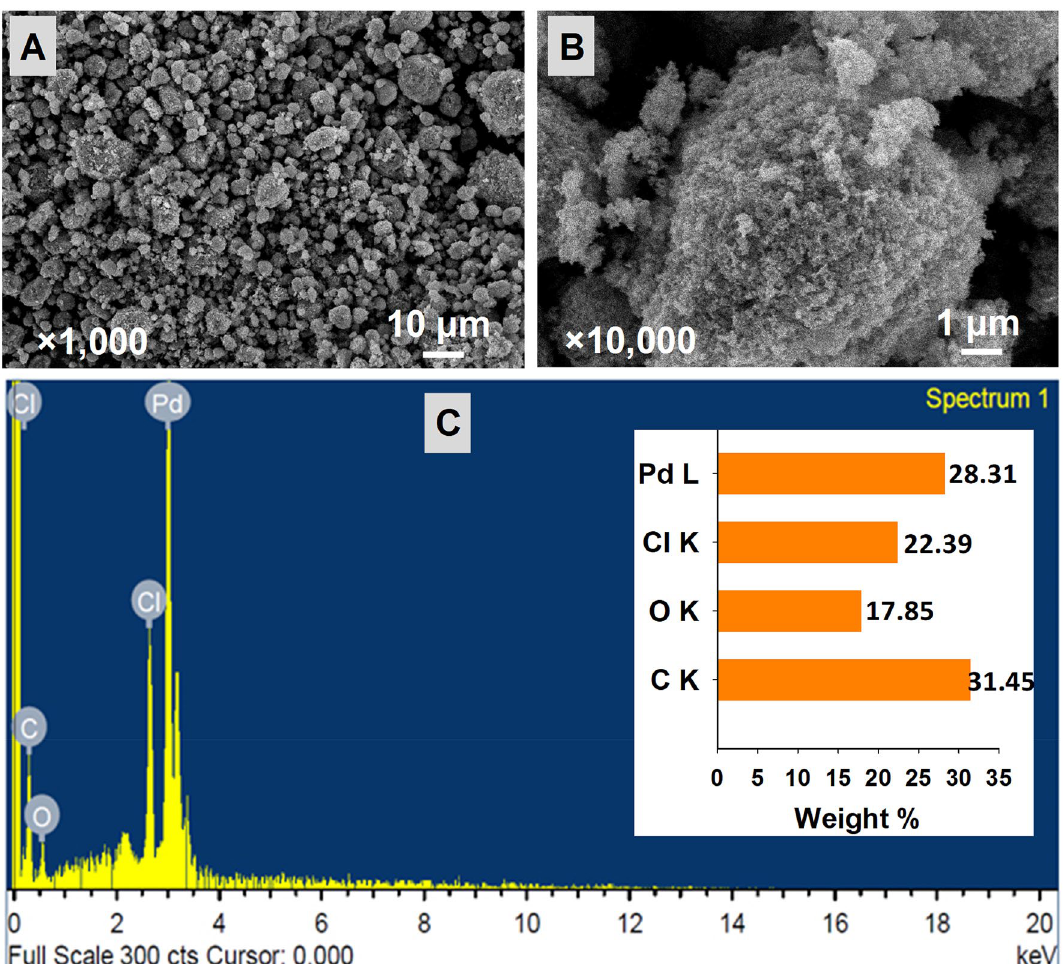
Figure 3. Determination of surface morphology of PB extract-capped Pd-NPs by SEM at × 1000 ( A ) and × 10,000 ( B ) magnification. Panelc C shows EDX analysis and elemental composition (inset of panel C) of synthesized